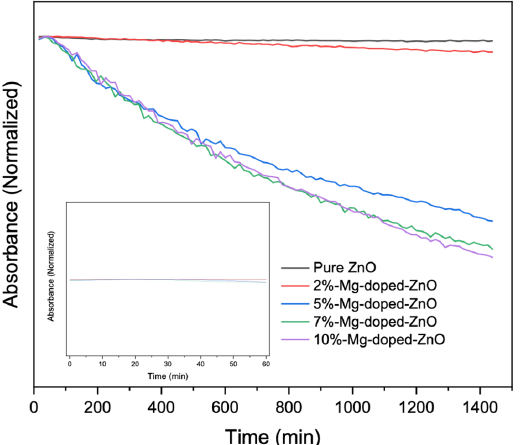
Figure 5. UV ‐ vis absorbance plot comparing the stability of pure and Mg ‐ doped ZnO nanoparticles. Figure 5. UV-vis absorbance plot comparing the stability of pure and Mg-doped ZnO nanoparticles. Inset: represents stability in the first 60 min. Inset: represents stability in the first 60